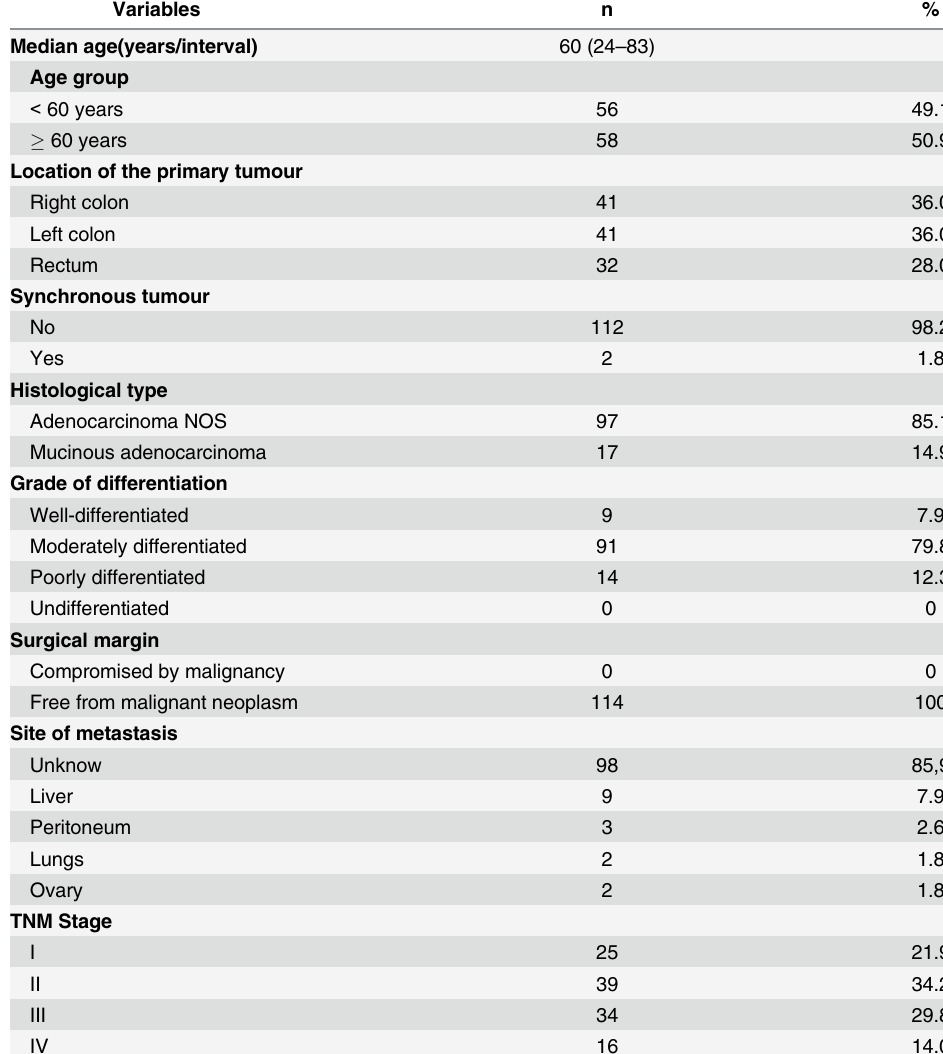
Table 1. Clinicopathological characteristics of the 114 patients included in this